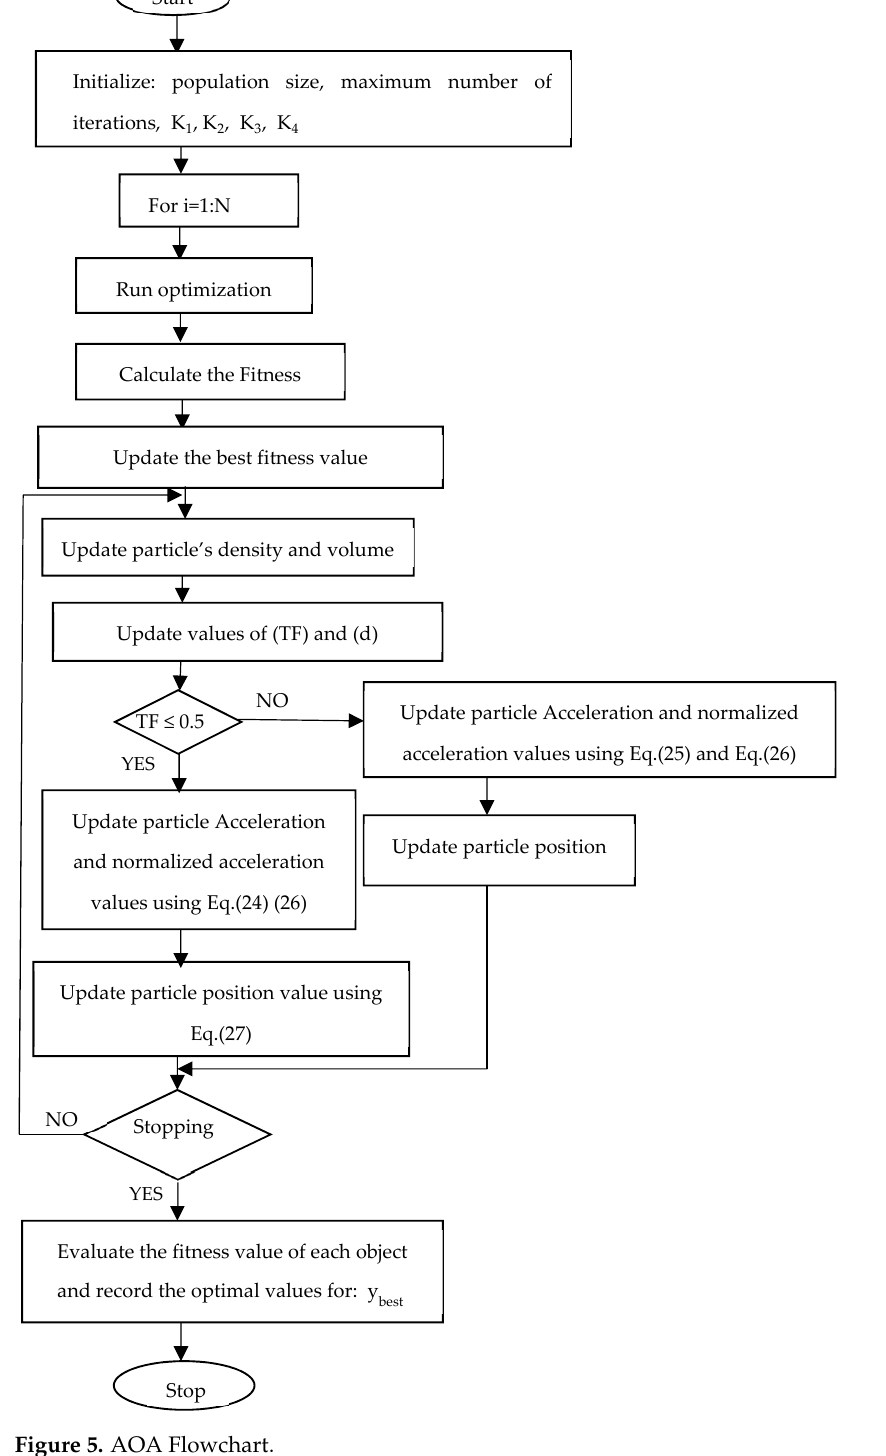
Figure 5. AOA Figure 5. AOA Flowchart.